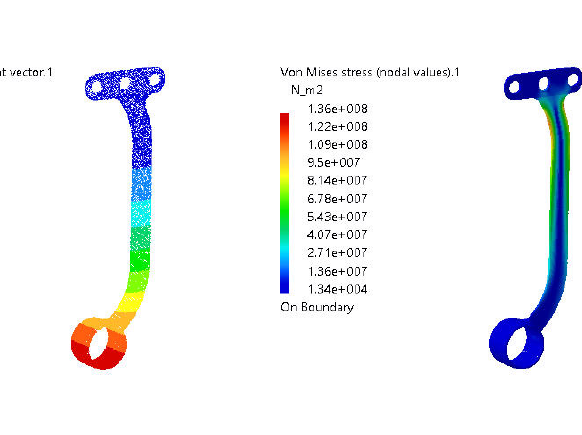
Figure 2: FEM Analysis in the Plough